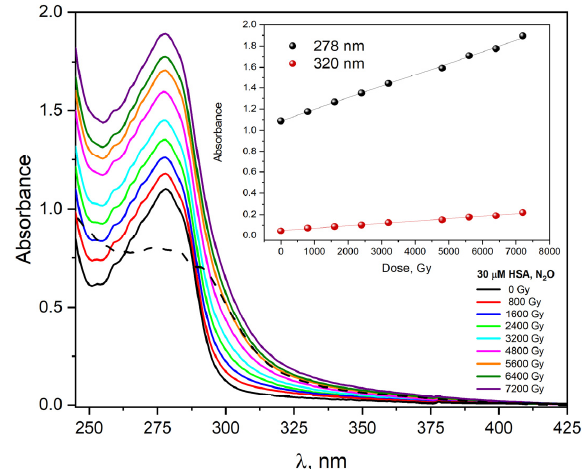
Figure 13. Absorbance spectra of N 2 O-saturated buffer solution of HSA (30 µM), obtained for irradiation doses between 0 and 7200 Gy. Insert : Dependence of A 278 nm and A 320 nm as a function of dose (0–7200 Gy).